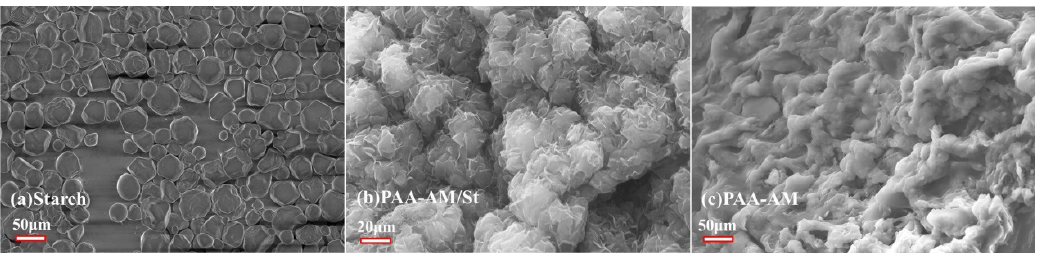
Figure 7. SEM images of ( a ) starch, ( b ) PAA-AM/St and ( c ) PAA-AM.